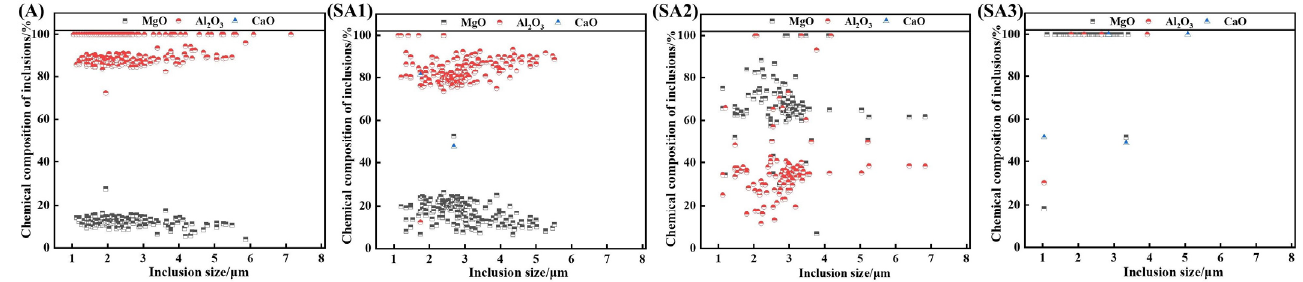
Figure 9. Chemical make-up of the inclusions in samples of steel.